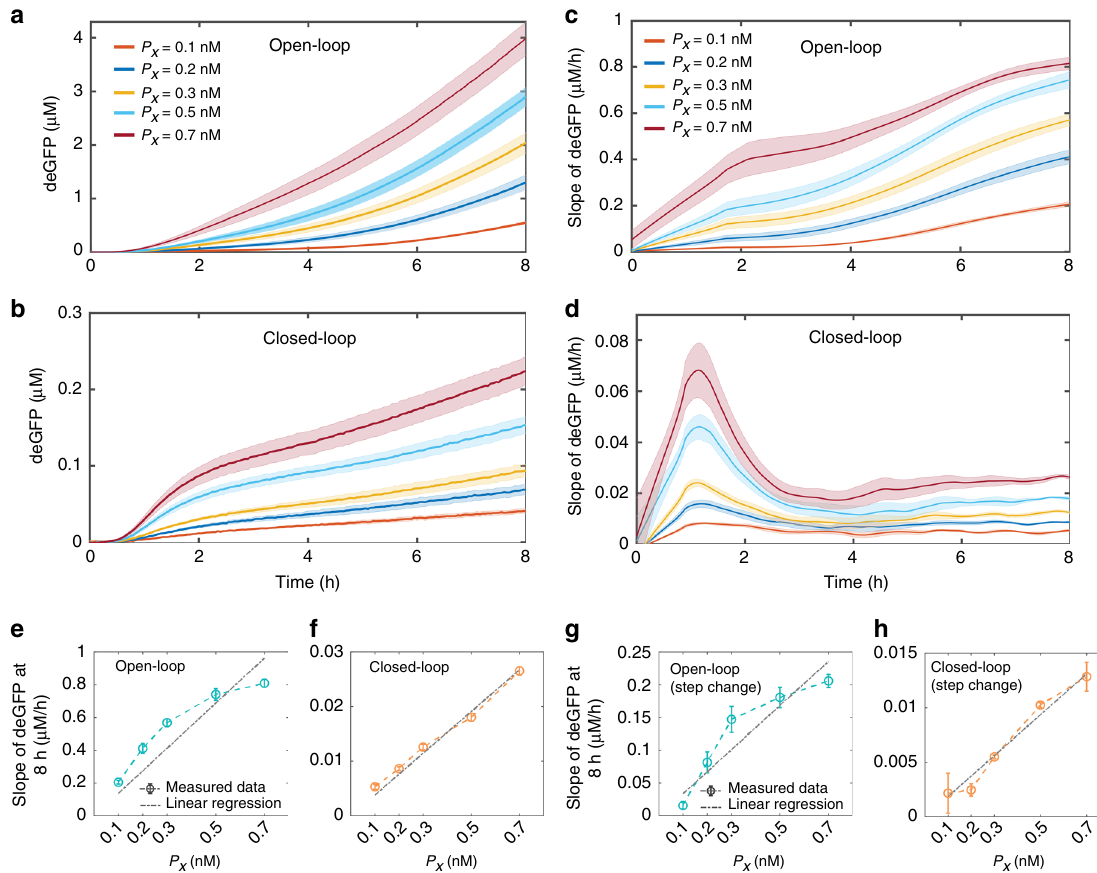
Fig. 2 The output follows the input signal linearly only in the closed-loop con fi guration. a, b TXTL deGFP measurement of the response of the integral controller in the a open-loop and b closed-loop con fi gurations at different initial concentrations of P X (0.1 – 0.7 nM) while initial P tot Y and P tot Z were both 1 nM each. In the open-loop, instead of P tot Y , P tot YC was added. c, d The slopes of measured deGFP responses for the c open-loop and d closed-loop operations and the corresponding summary in e and f at 8 h respectively. To disable the feedback in the open-loop case P tot Y was replaced by P tot YC , which expresses a protein that cannot sequester with X . g, h Summary of the deGFP slopes of the controller at 8 h for a step change in P X for the g open-loop and h closed-loop operations. P X was increased from 0 nM to different concentrations (0.1 – 0.7 nM) after 4 h of the reaction in the presence of initial 1 nM of P tot Y and P tot Z each. Note that the lower GFP slope values in g, h than e, f are due to the shorter active reaction time. Error are shown in the shaded region and were determined using the standard error of the mean of three or more repeats. A linear regression with zero intercept was used to fi t the deGFP slopes and the corresponding R -square values are e 0.71, f 0.98, g 0.84, and h 0.98. A calibration factor was used to convert the measured deGFP fl uorescent signal into the concentration. Before calculating deGFP slopes, measured deGFP responses were smoothed-out using the rloess smoothing method in MATLAB. Source data are provided as a Source Data fi